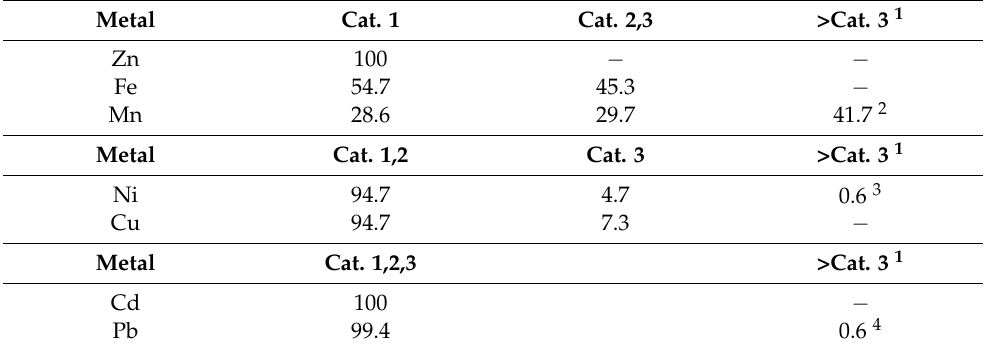
Table 4. Percentage of investigated samples in a specific water category (in total in 2018 and